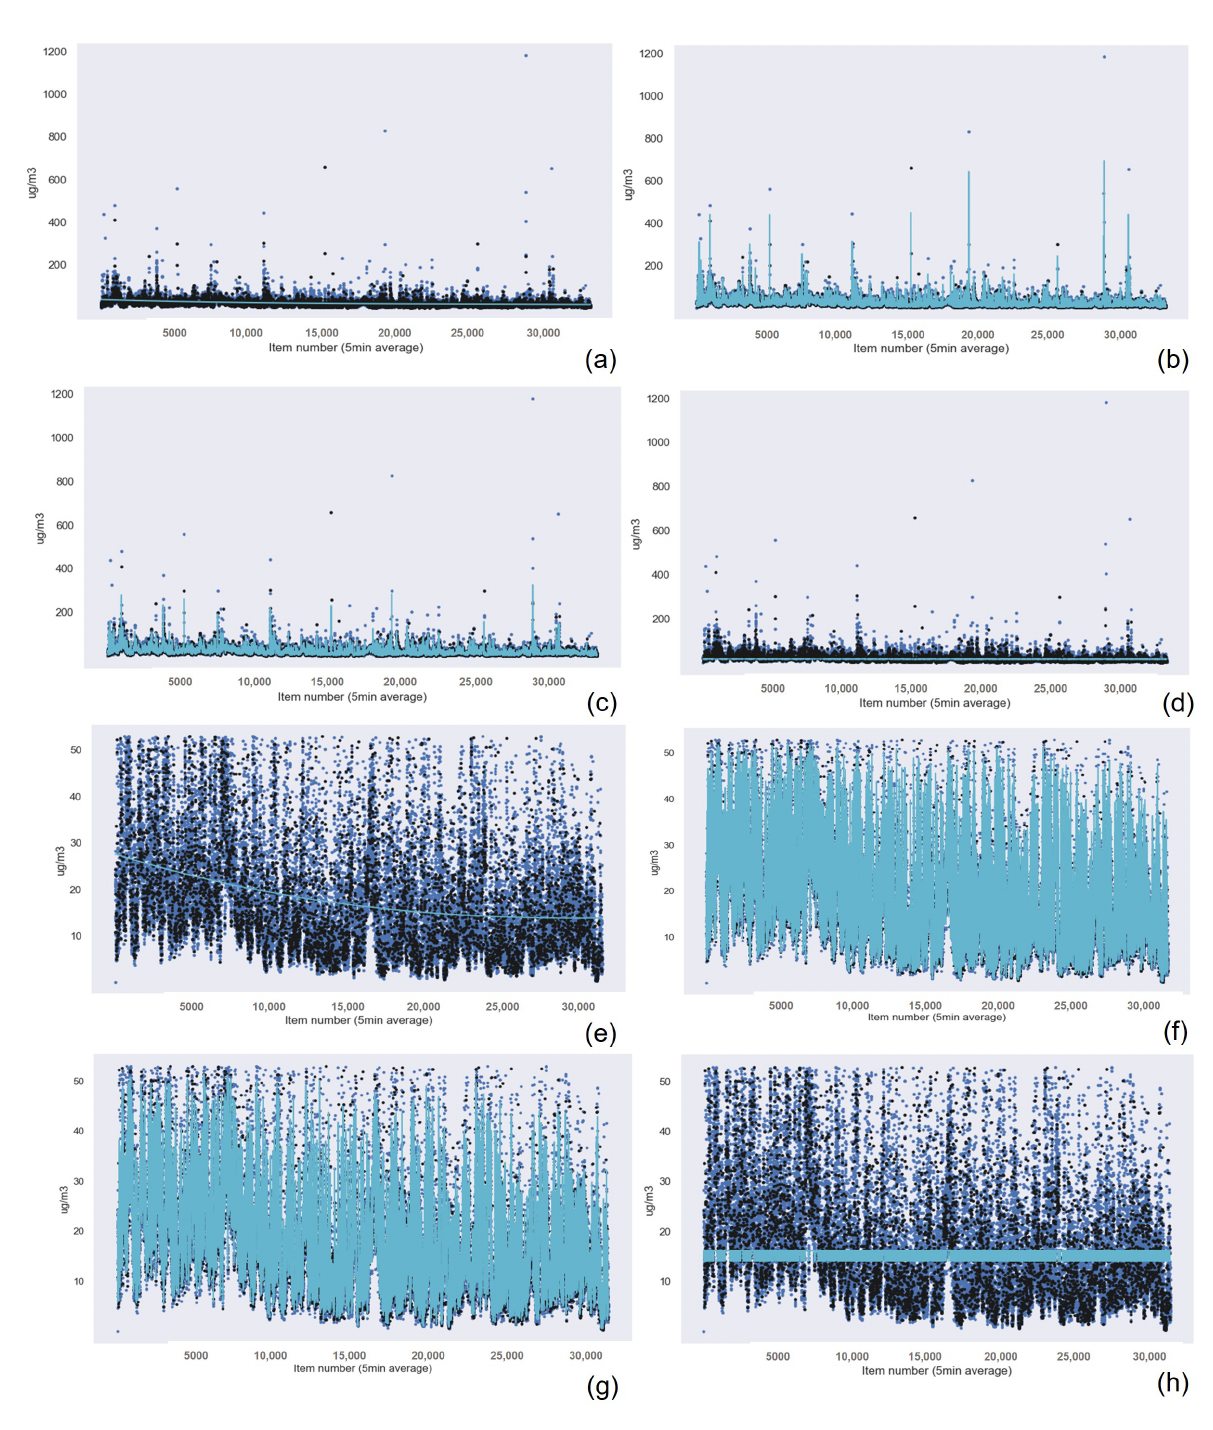
Figure A12. PM 10 results of the articulate matter measuring device # 1 with outliers for ( a ) Linear Re- gression ( b ) Random Forest Regression ( c ) KNN and ( d ) Support Vector Machine, and without outliers for ( e ) Linear Regression ( f ) Random Forest Regression ( g ) KNN and ( h ) Support Vector